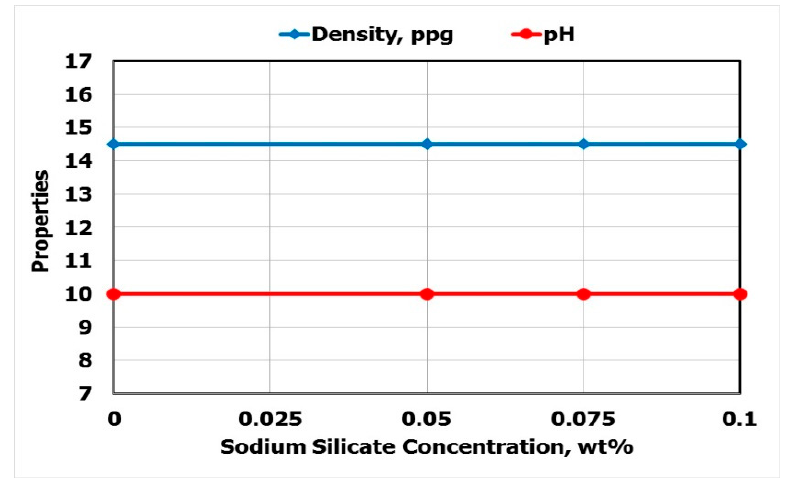
Figure 1. Effect of adding sodium silicate on drilling fluid density and pH at room temperature. Figure 1. E ff ect of adding sodium silicate on drilling fluid density and pH at room